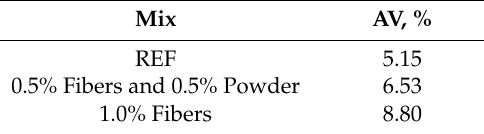
Table 2. Air void properties of the